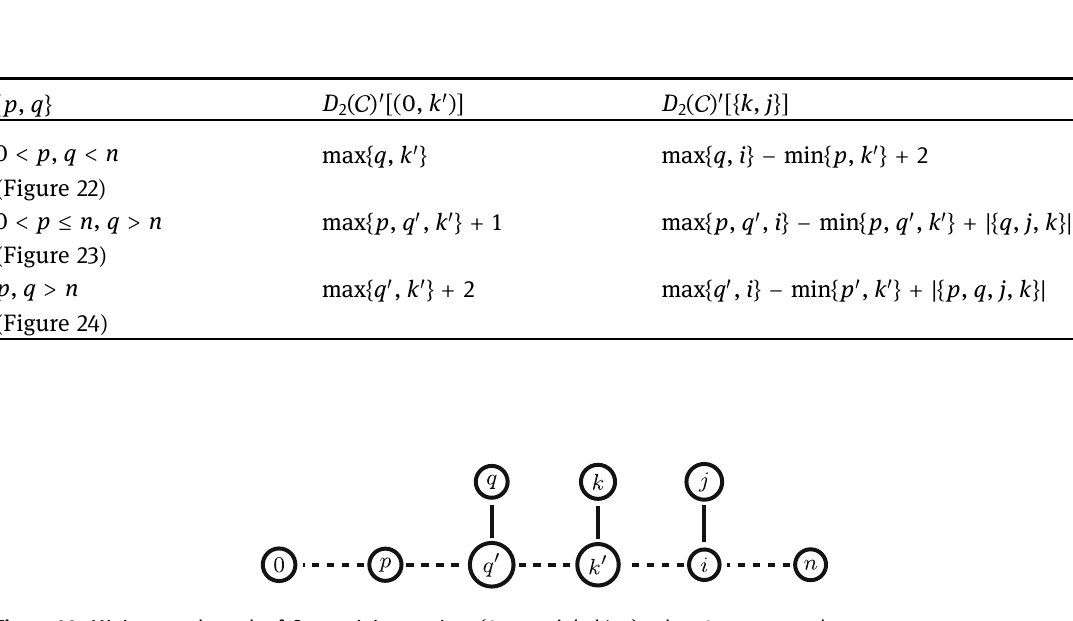
Figure 23: Minimum subgraph of C containing vertices {